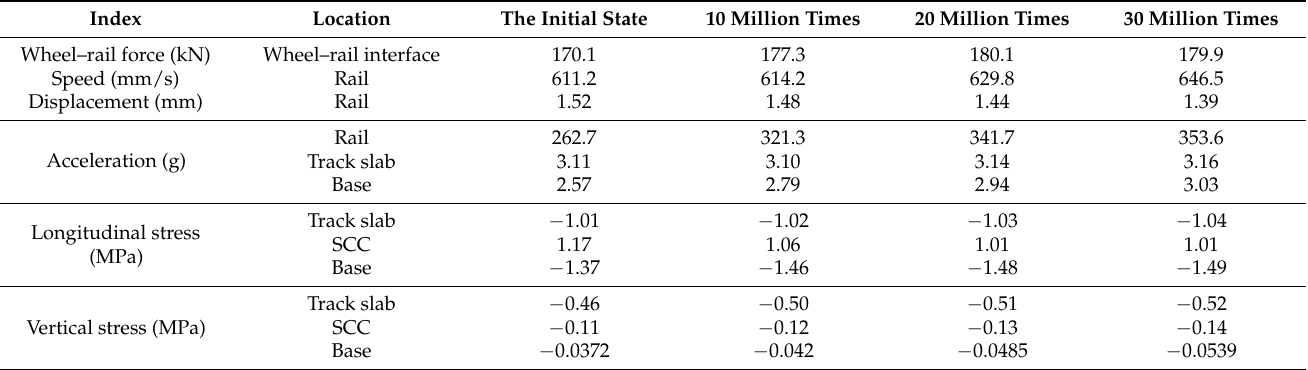
Table 4. Comparison of maximum dynamic response of track structure surface under axle